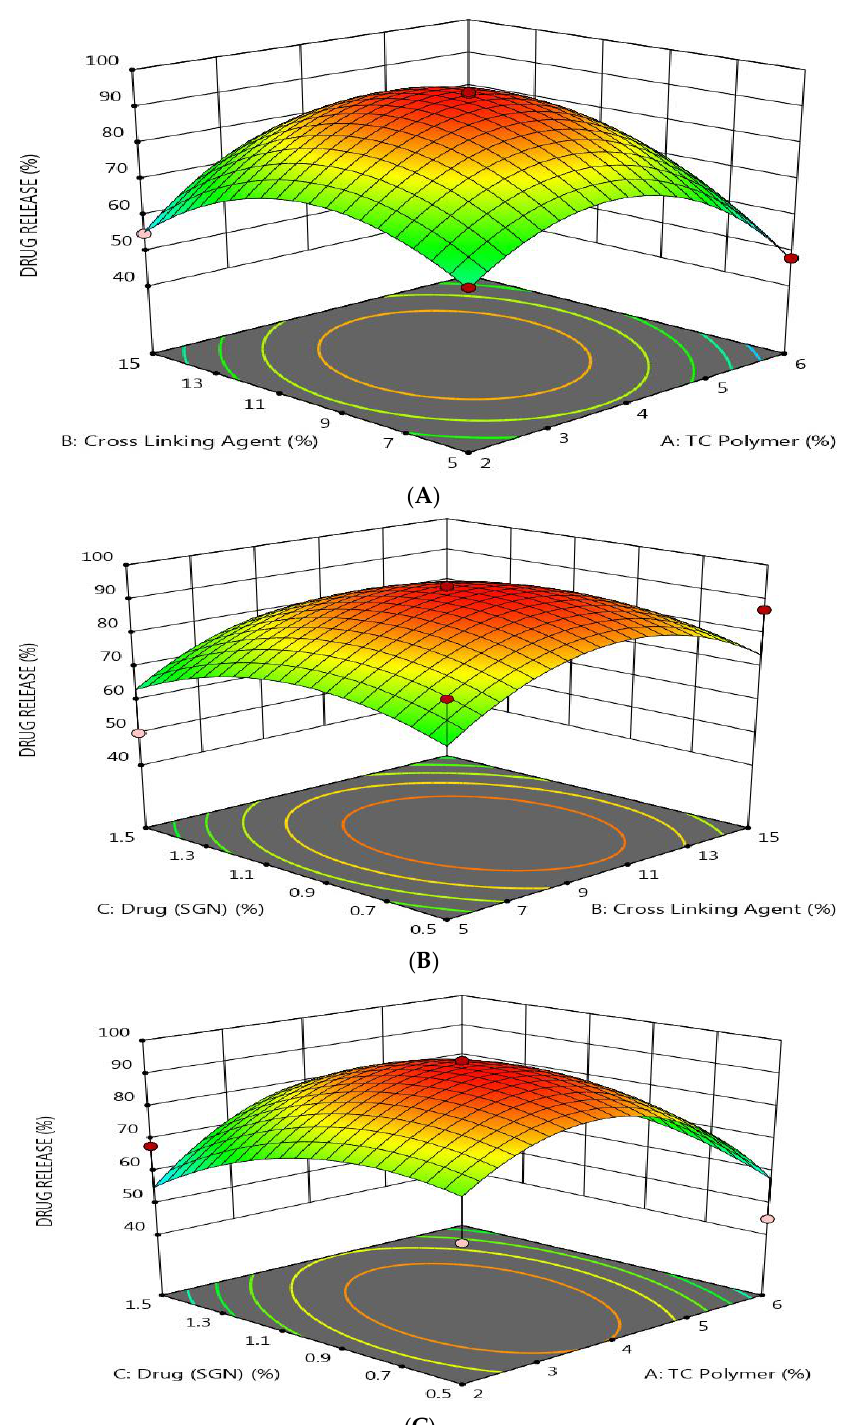
Figure 3. Response surface methodology for the effect of the formulation factors (X 1 , X 2 , and X 3 ) on the drug release of SGN–TC nanoparticles. ( A ) Effect of polymer and crosslinking agent concentration on drug release %, ( B ) Effect of crosslinking agent and drug concentration on drug release %, ( C ) Effect of polymer and drug concentration on drug release %.